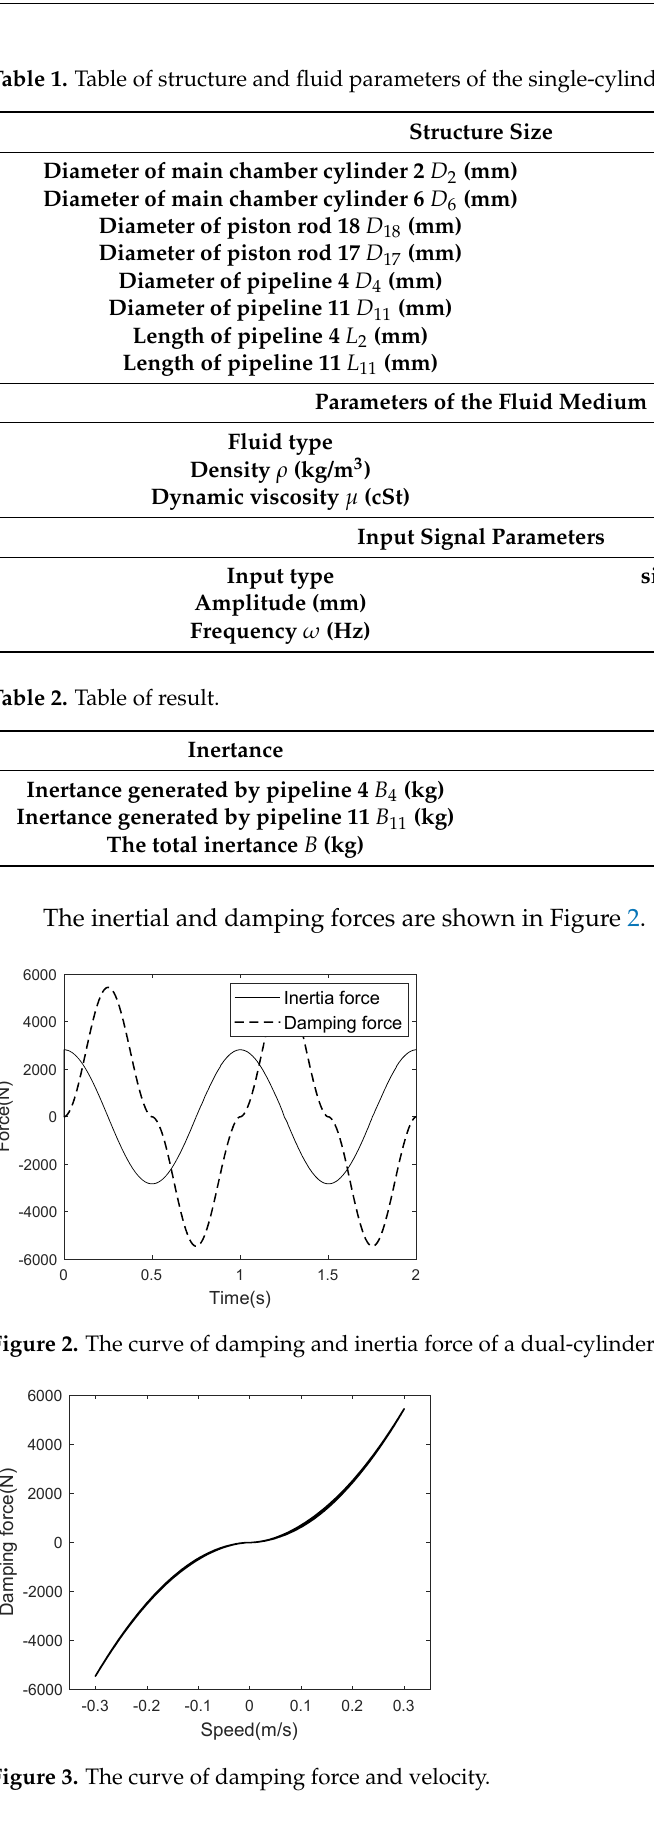
Figure 4. The curve of inertia force and acceleration. In Figure 5, the solid line is the resultant force calculated by Formula (16), and the dotted line is the result calculated by Simulink/Hydraulic Segmented Pipe LP. The Seg- mented Pipe LP module could consider the inertia force and damping force of the fluid simultaneously. “The Segmented Pipe LP” module in Simulink was based on the finite- element idea. Except in the initial stage of loading, there was shock in the Segmented Pipe LP module, and after stabilizing, the results of the above two methods were highly